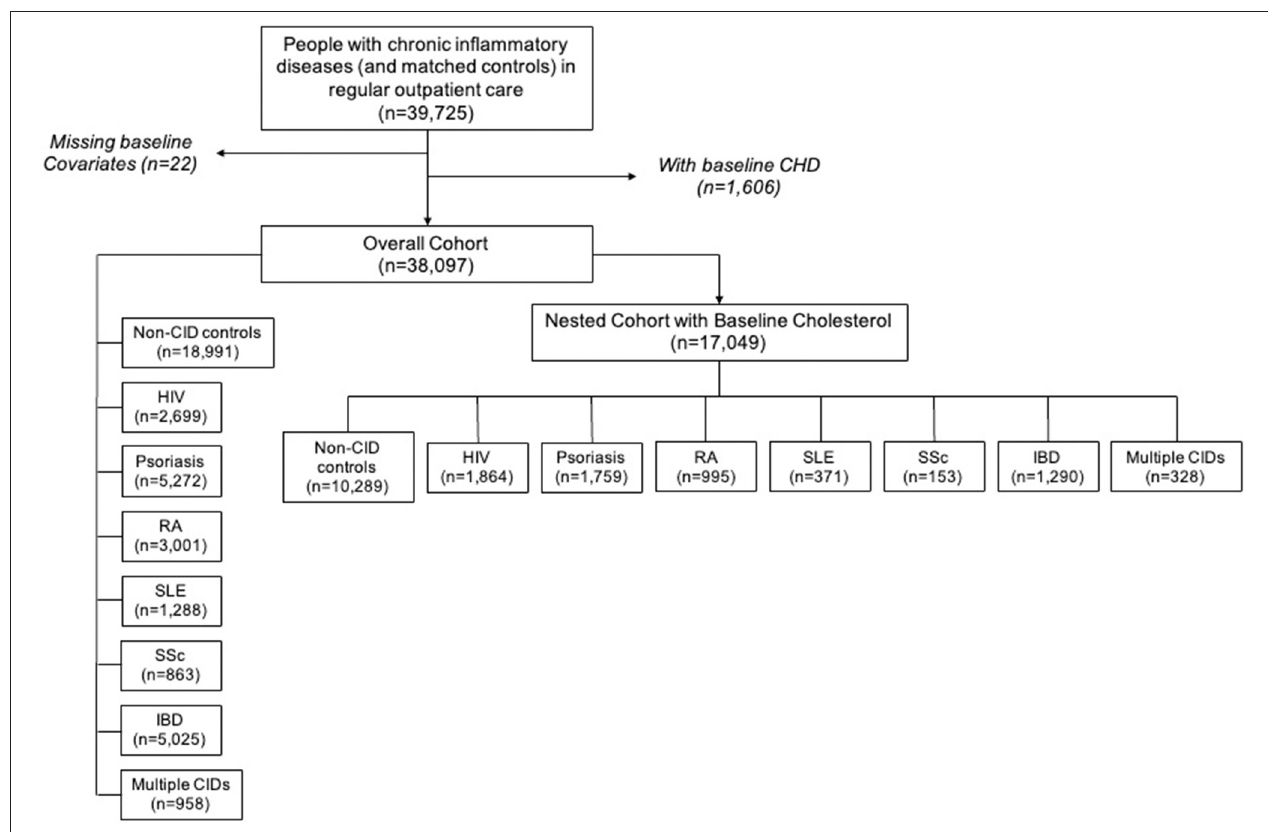
FIGURE 1 | Chronic inflammatory disease cohort creation flow diagram. CHD, coronary heart disease; CID, chronic inflammatory disease; HIV, human immunodeficiency virus; RA, rheumatoid arthritis; SLE, systemic lupus erythematosus; SSc, systemic sclerosis; IBD, inflammatory bowel